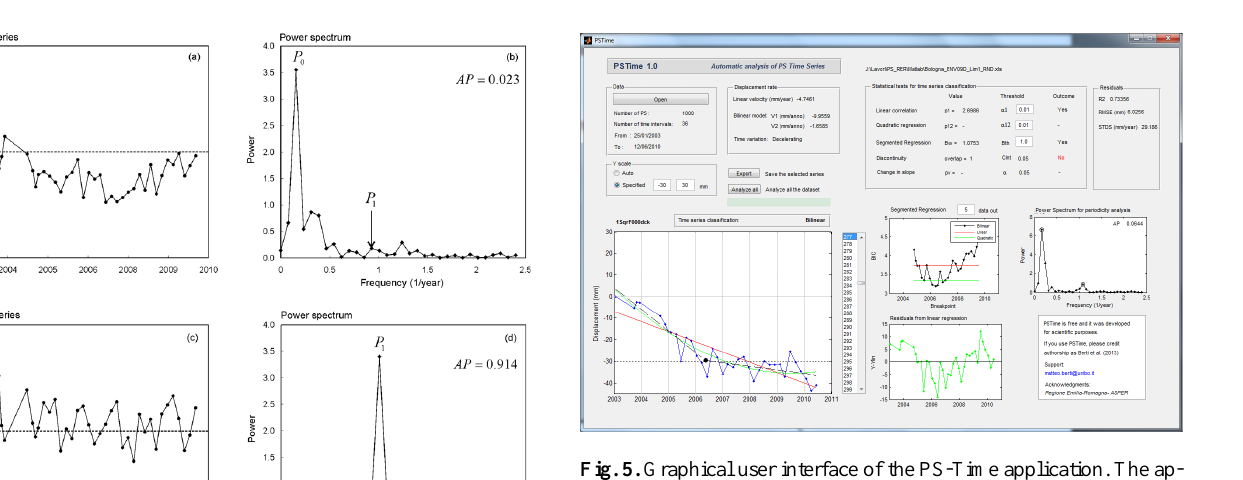
Fig. 5. Graphical user interface of the PS-Time application. The ap- plication is freely available at http://www.bigea.unibo.it/it/ricerca/